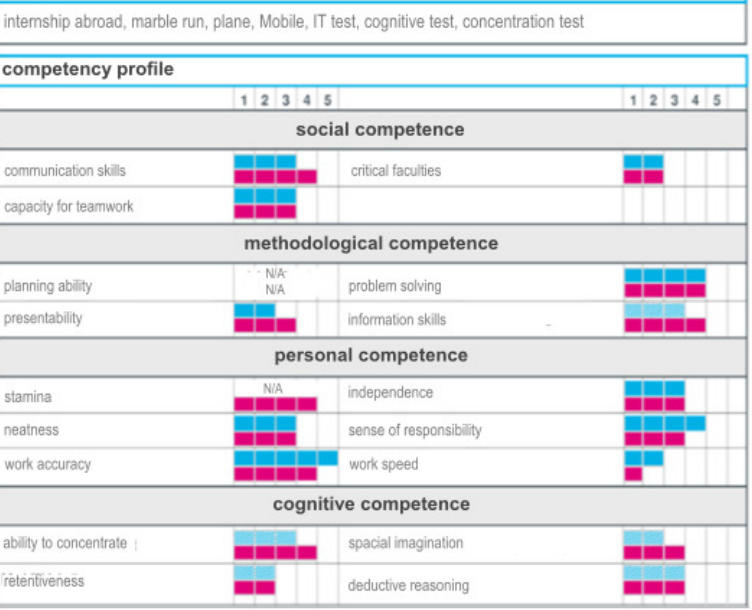
Figure 2. Graphic illustration of competencies in competency